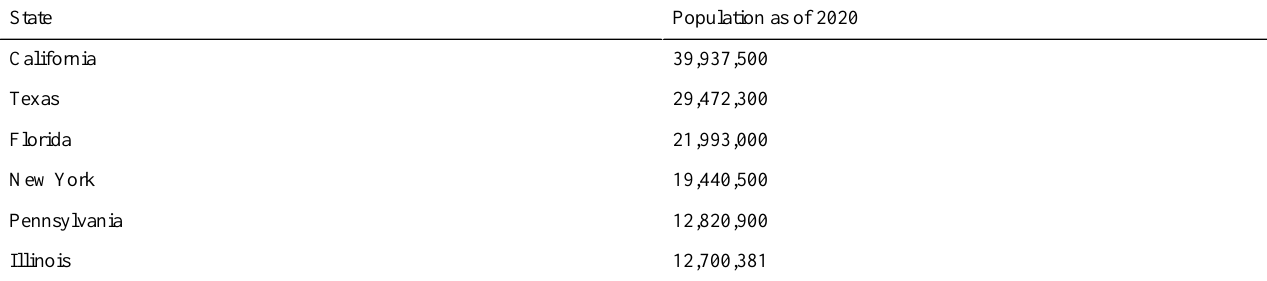
Table 3. Most populous US states.